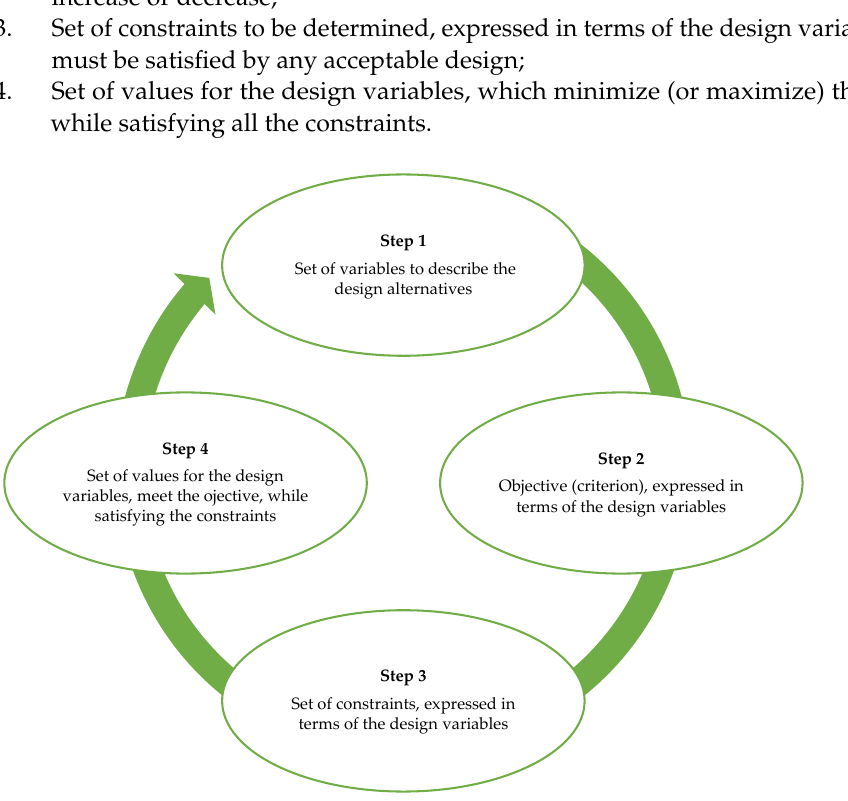
Figure 2. Engineering optimization steps for rated buildings [11].